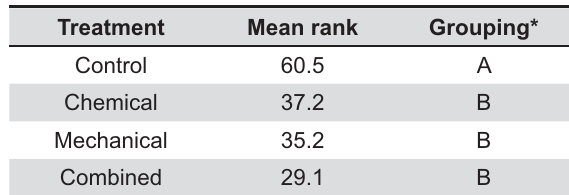
Table 2- Mean ranks for the treatments and results for Dunn multiple comparison test